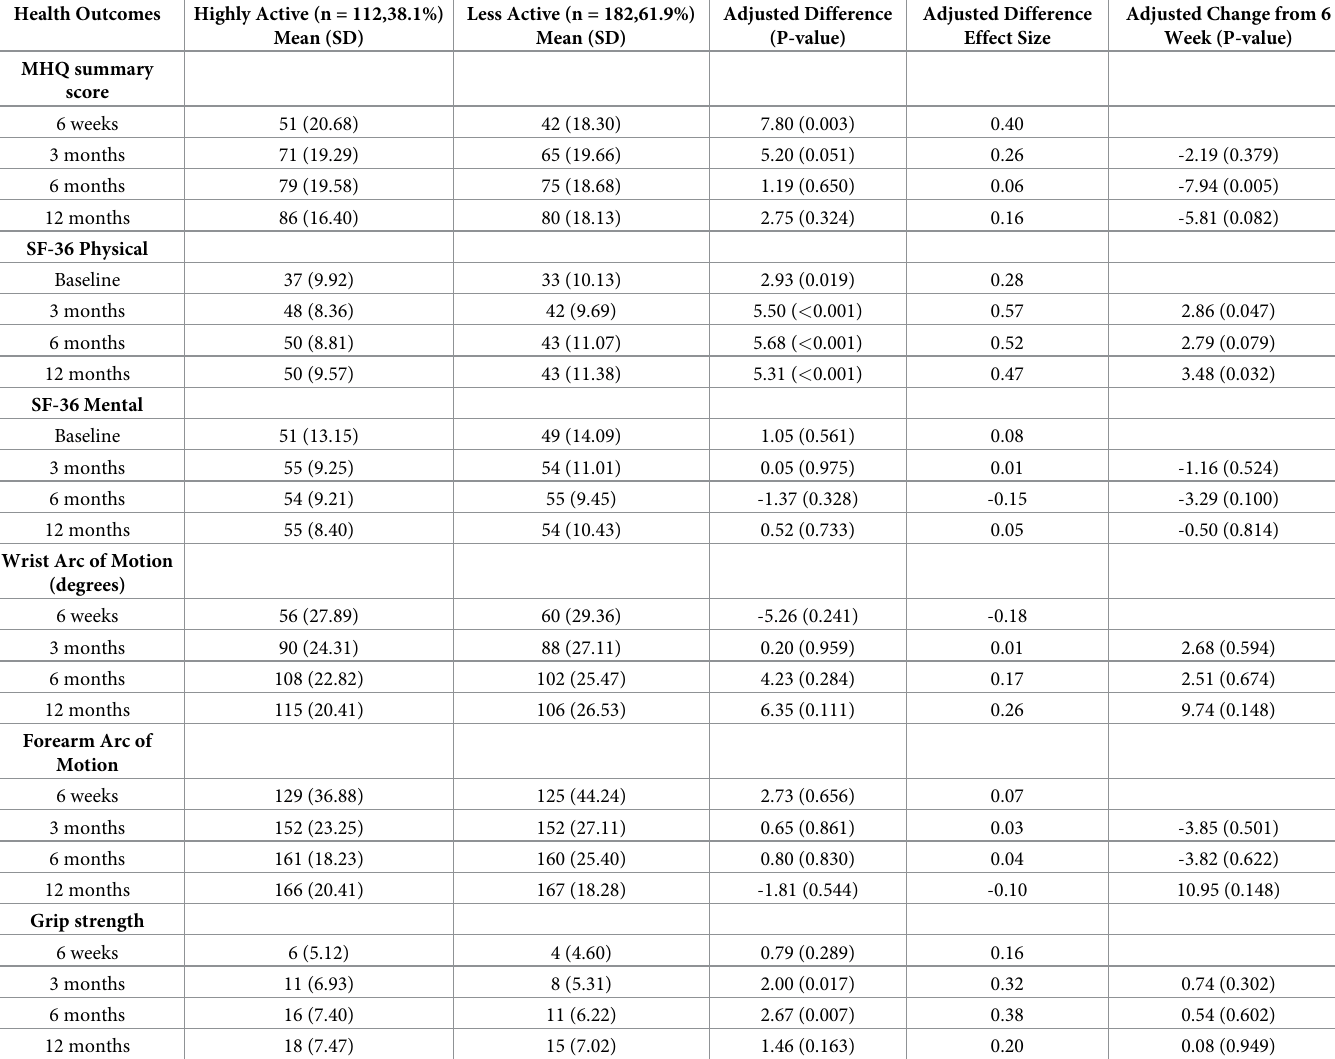
Table 3. Patient-reported and functional outcome comparisons between highly and less-active participants. Health Outcomes Highly Active (n = 112,38.1%) Mean